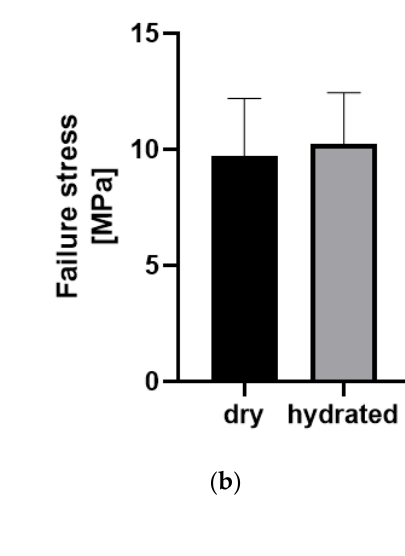
Figure 5. ( a ) Appearance of electrospun BMSF/PCL scaffolds after fabrication before the immersion in ethanol or PBS. Scale bar = 2 mm; ( b ) SEM micrographs of electrospun BMSF/PCL scaffolds (top view). Scale bar = 20 µm.